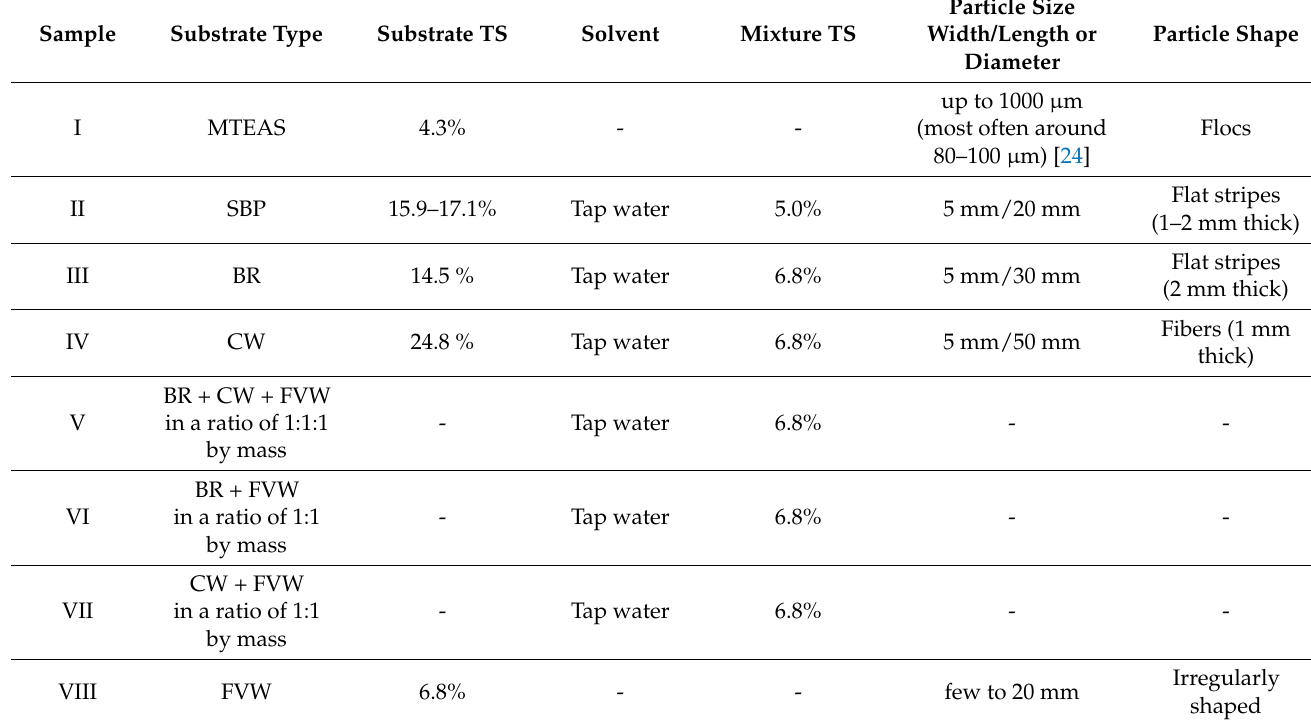
Table 4. Types of